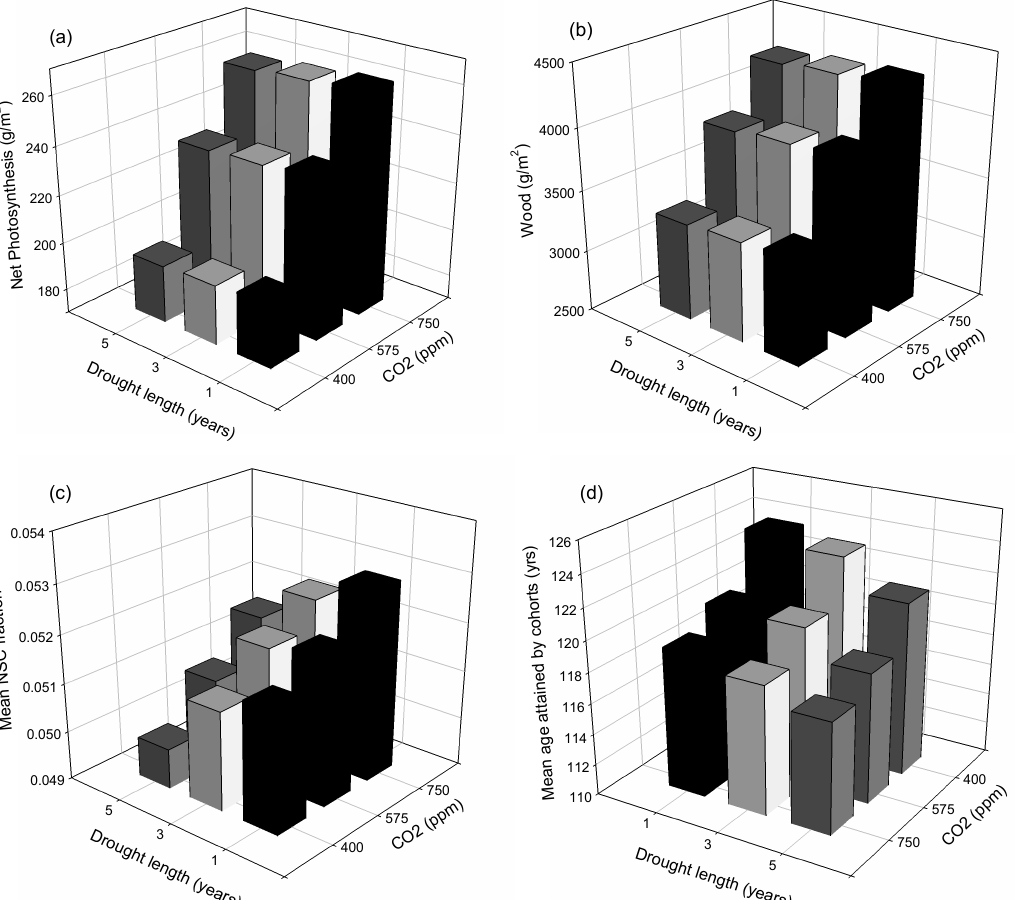
Figure 4. Mitigating effect of CO 2 on the negative drought length effect for the four response variables. Note axes inversions in ( d ).